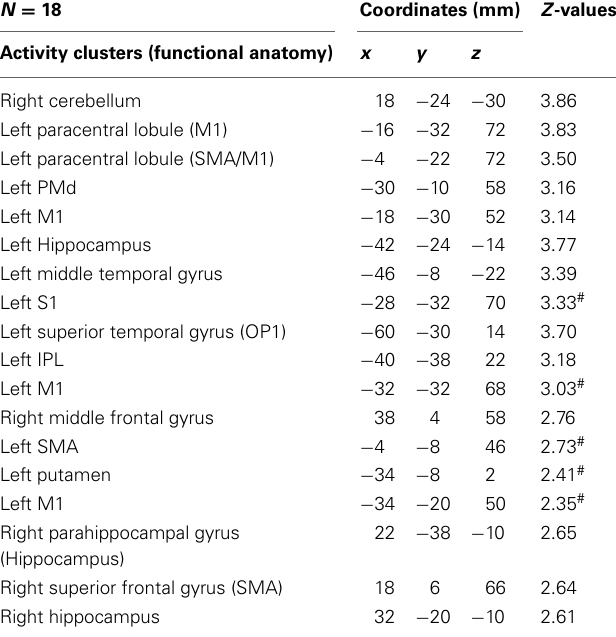
Table 1 | Results of group-level statistical parametric mapping